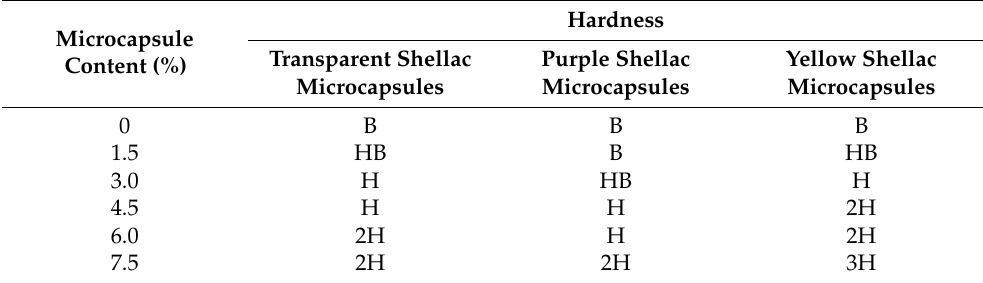
Table 6. The hardness of the coating on Beli wood with the content of different shellac microcapsules in the